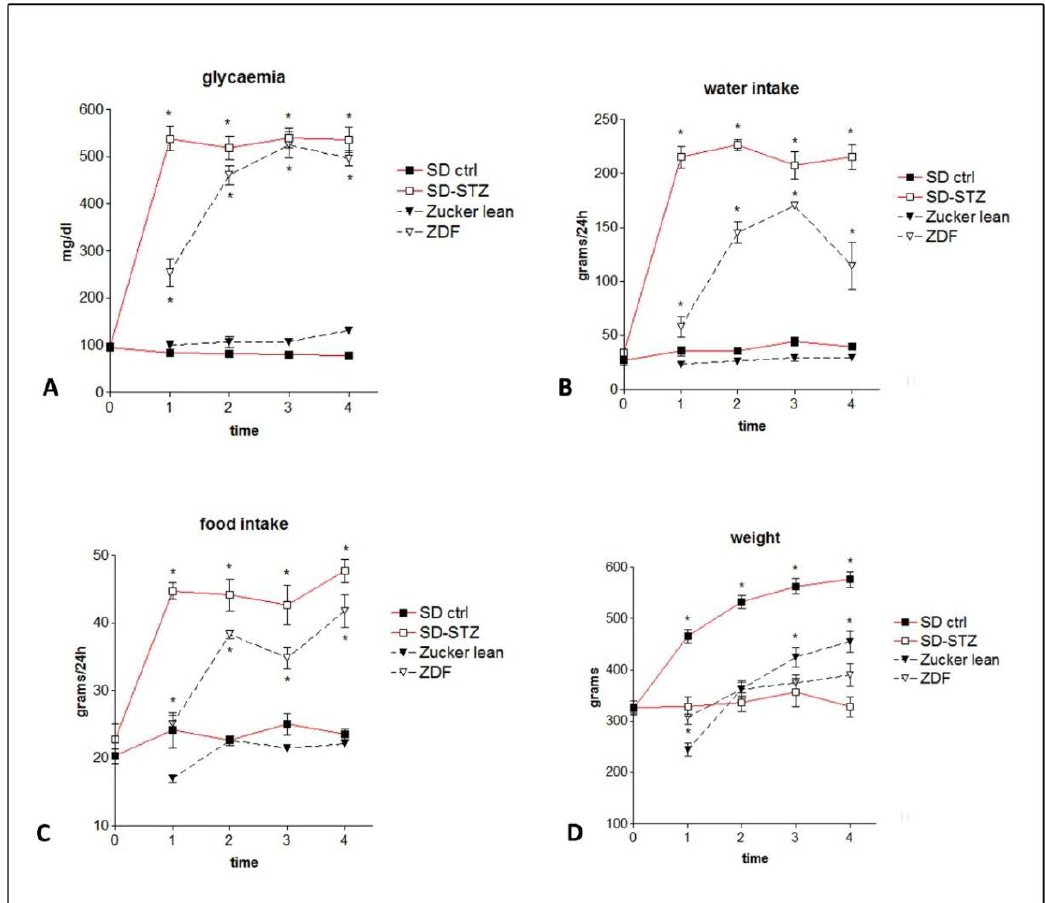
Figure 2. Weekly changes in glycaemia ( A ), food consumption ( B ), water intake ( C ), and body weight ( D ); SD-STZ and ZDF diabetic rats are compared with their non-diabetic controls at the different time points as follows: 0 = at the moment of STZ injection; 1 = 8 weeks after STZ injection (SD-STZ rats) or 8 weeks of age (ZDF rats); 2 = 16 weeks after STZ injection (SD-STZ rats) or 16 weeks of age (ZDF rats); 3 = 24 weeks after STZ injection (SD-STZ rats) or 24 weeks of age (ZDF rats); 4 = 32 weeks after STZ injection (SD-STZ rats) or 32 weeks of age (ZDF rats). Values represent mean +/ − SEM (*) = p < 0.001 .